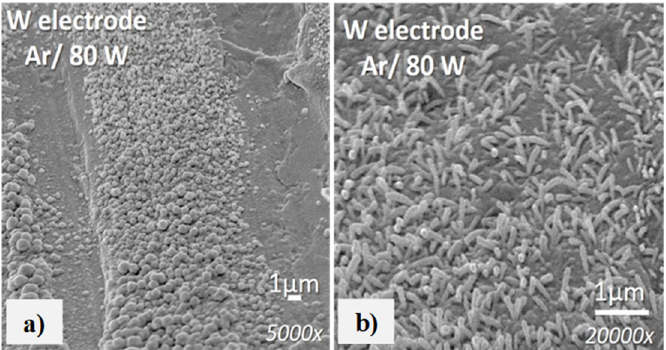
Figure 12. Margin zone_SEM images of W surface electrodes exposed to Ar-MD: ( a ) Particles; ( b ) nanofibers.